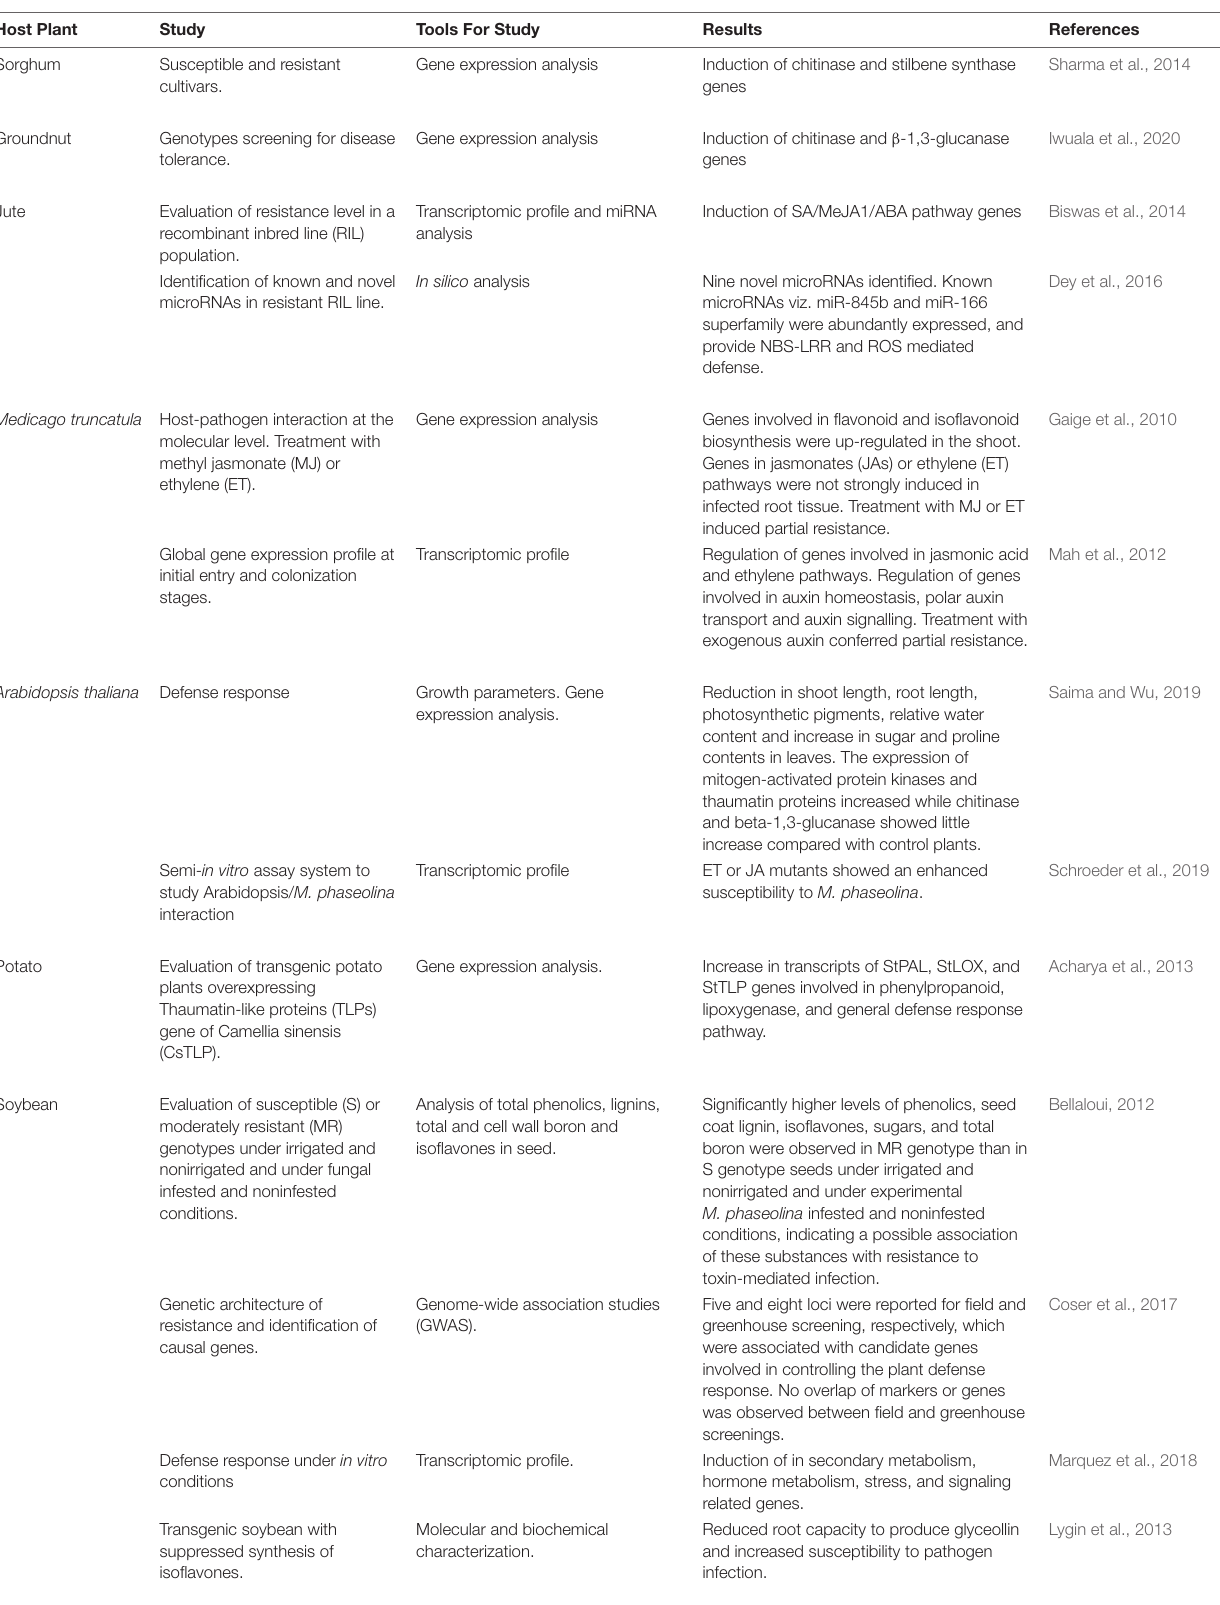
TABLE 1 | Study of the interactions between several host plants and Macrophomina